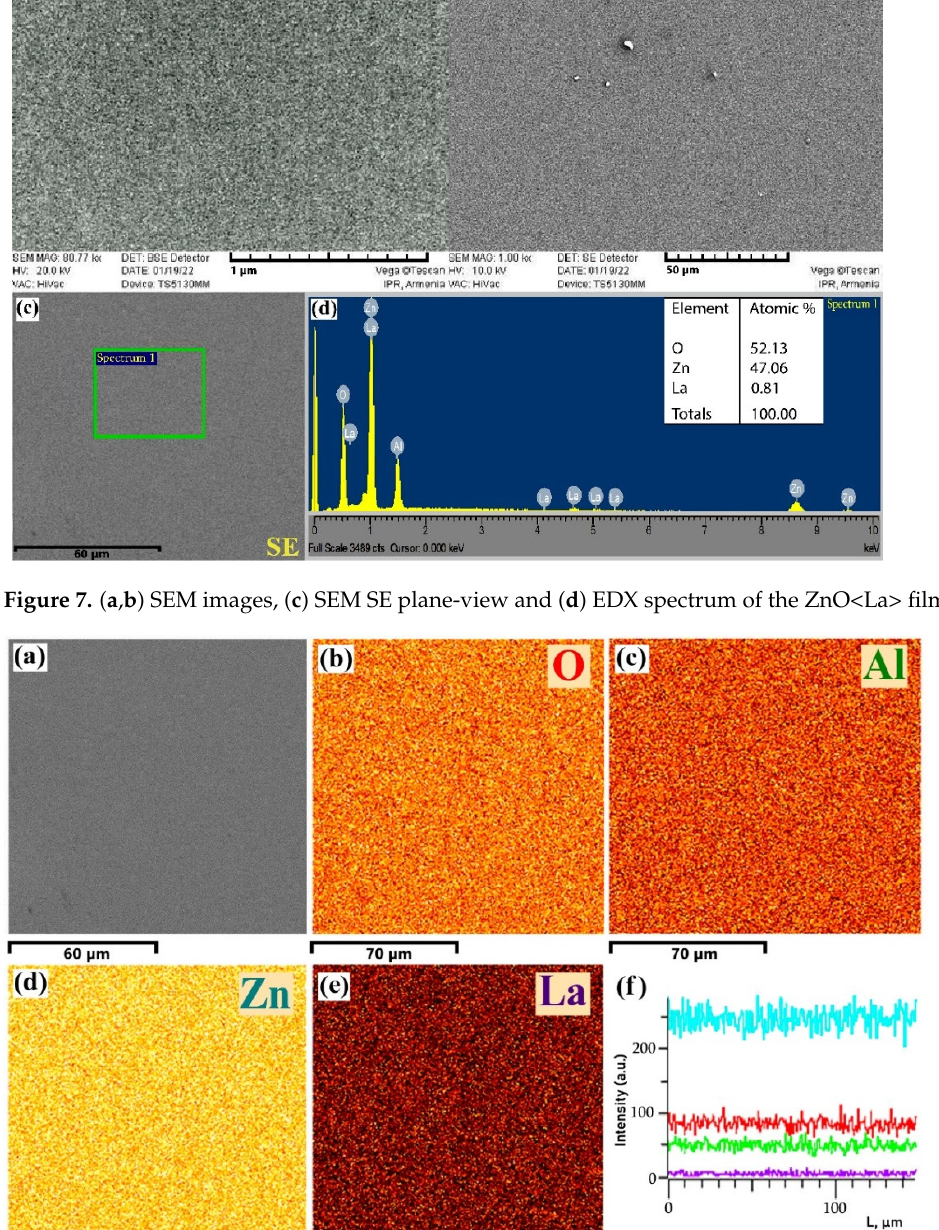
Figure 8. ( a ) SEM image, ( b – e ) EDX elemental mapping analysis of Zn, Al, O, and La, and ( f ) X-ray intensity of characteristic lines of different elements.